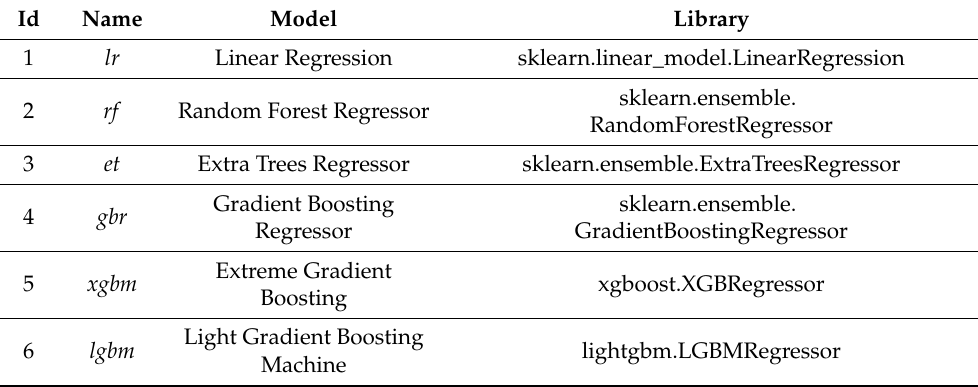
Table 3. Machine learning algorithms used.